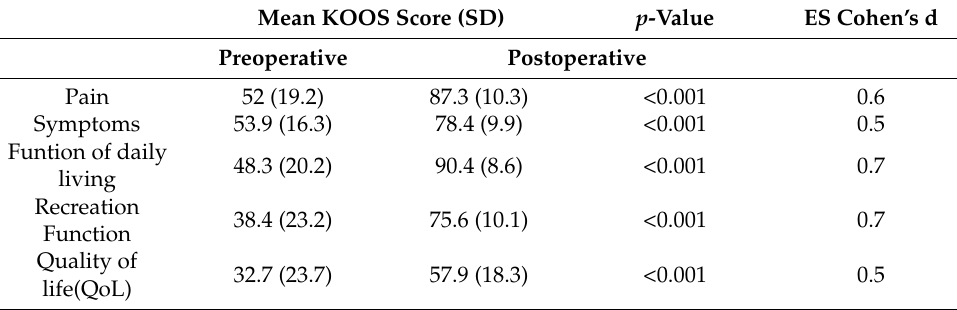
Table 1. Patients’ preoperative and postoperative KOOS